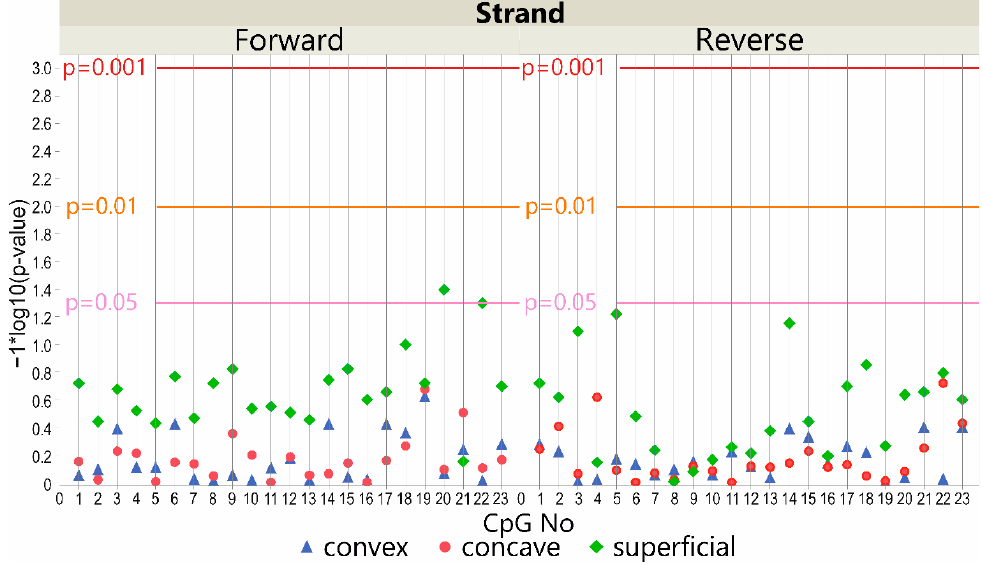
Figure 1. Scatter plot of − log10 p -values showing the difference between controls and patients in methylation level at LBX1 DNA forward strand (left) and DNA reverse strand (right) promoter CpG sites in deep convex (blue triangles), deep concave (red triangles), and superficial (green diamonds) muscles. Reference horizontal lines represent the p -values.